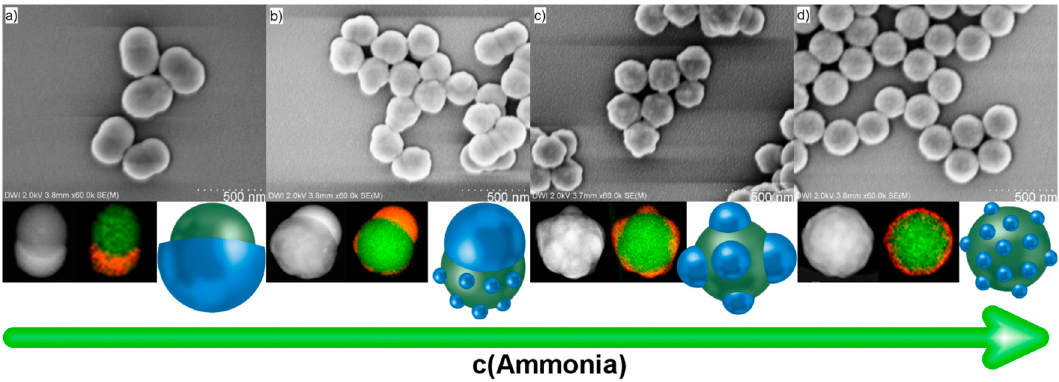
Figure 3. SEM images, TEM images, EDS mappings, and schematic representations of composite particles synthesized with ( a ) 0.18 M (pH = 11.25), ( b ) 0.21 M (pH = 11.29), ( c ) 0.27 M (pH = 11.34), and ( d ) 0.36 M (pH = 11.40) ammonia concentrations (for EDS: green = carbon, red =